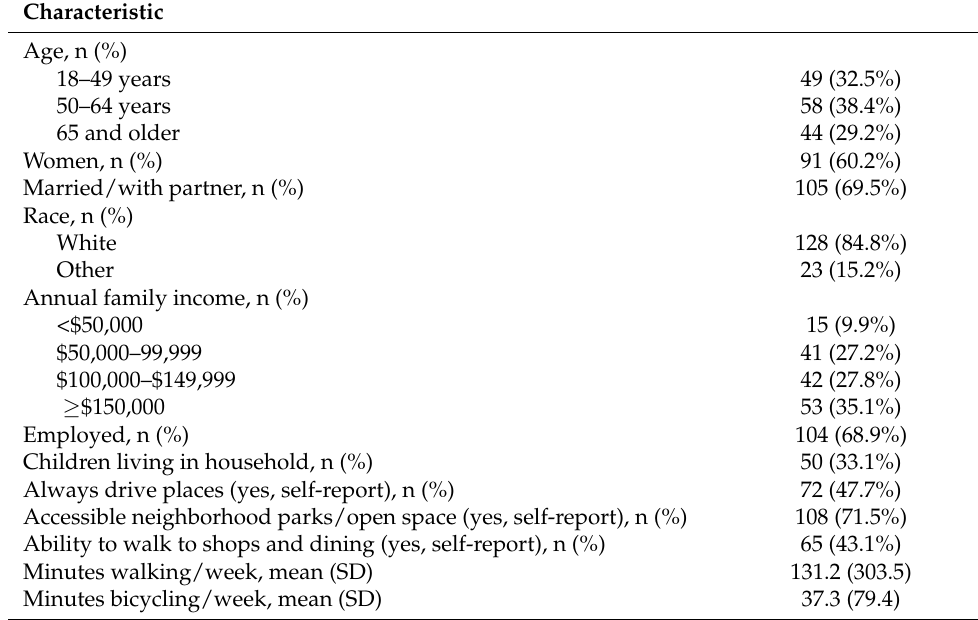
Table 3. Case Study 1 Participant Characteristics.